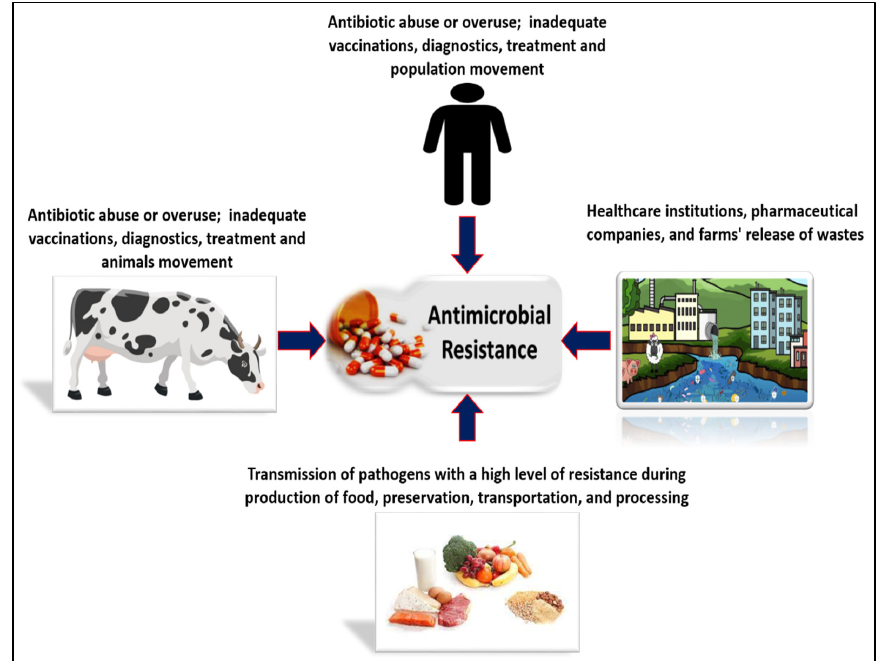
Figure 1. Components of the “One-Health Concept” to combat AMR.